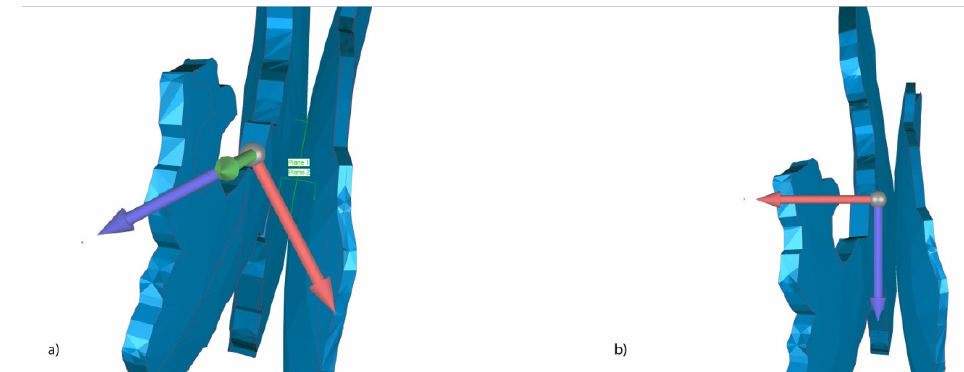
Figure 6. ( a ) Point of contact between the mesial and distal interproximal enamel reduction meshes before and ( b ) after being aligned perpendicular to the “X” axis.